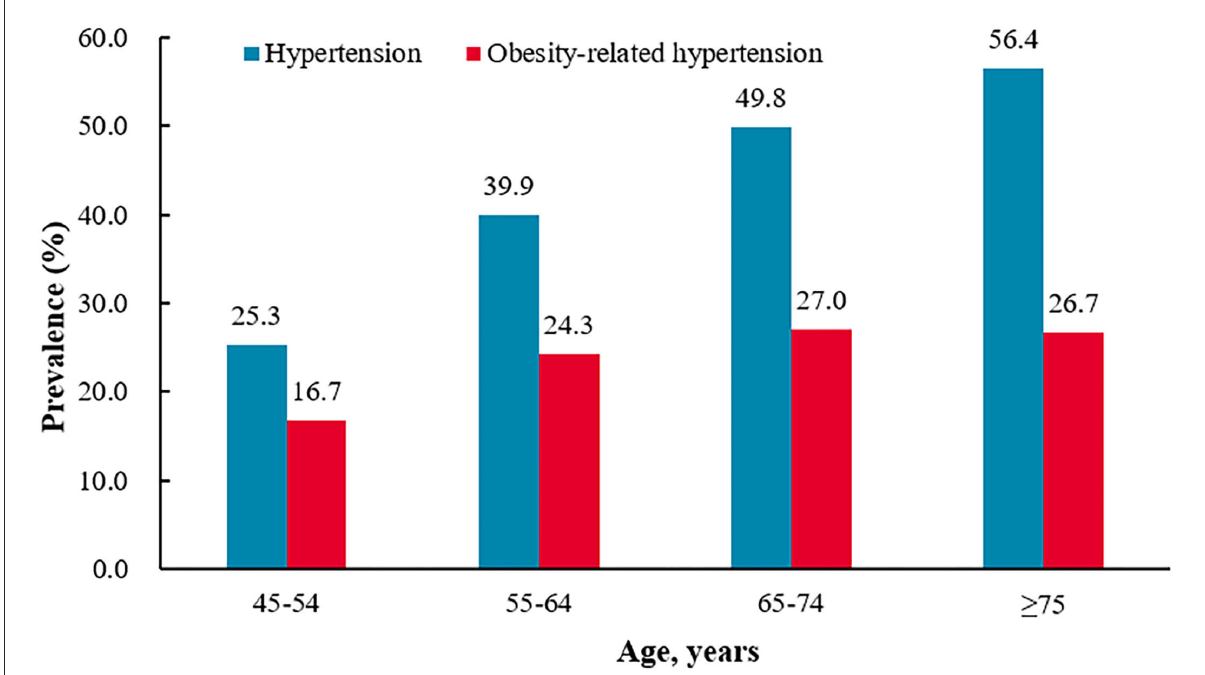
FIGURE2 The prevalence of hypertension and obesity-related hypertension different age groups. † P -trend < 0.0001 for the trend in the prevalence of hypertension by age groups. ‡ P -trend < 0.0001 for the trend in the prevalence of obesity-related hypertension by age groups. * P = 0.8806 for the difference in the prevalence of obesity-related hypertension between 65–74 age group and > 75 age group.